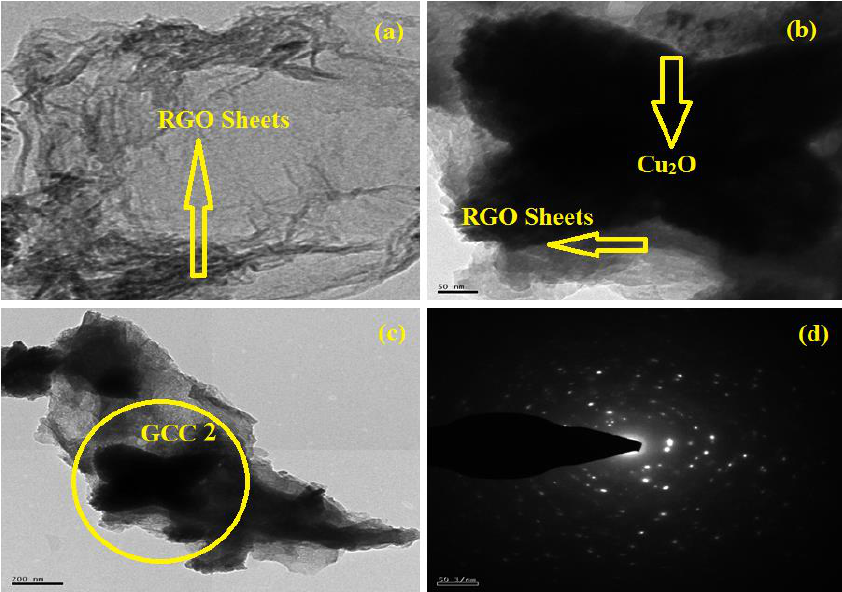
Figure 8. HRTEM pictures of ( a ) RGO, ( b , c ) GCC 2, and ( d ) SAED pattern of GCC 2.